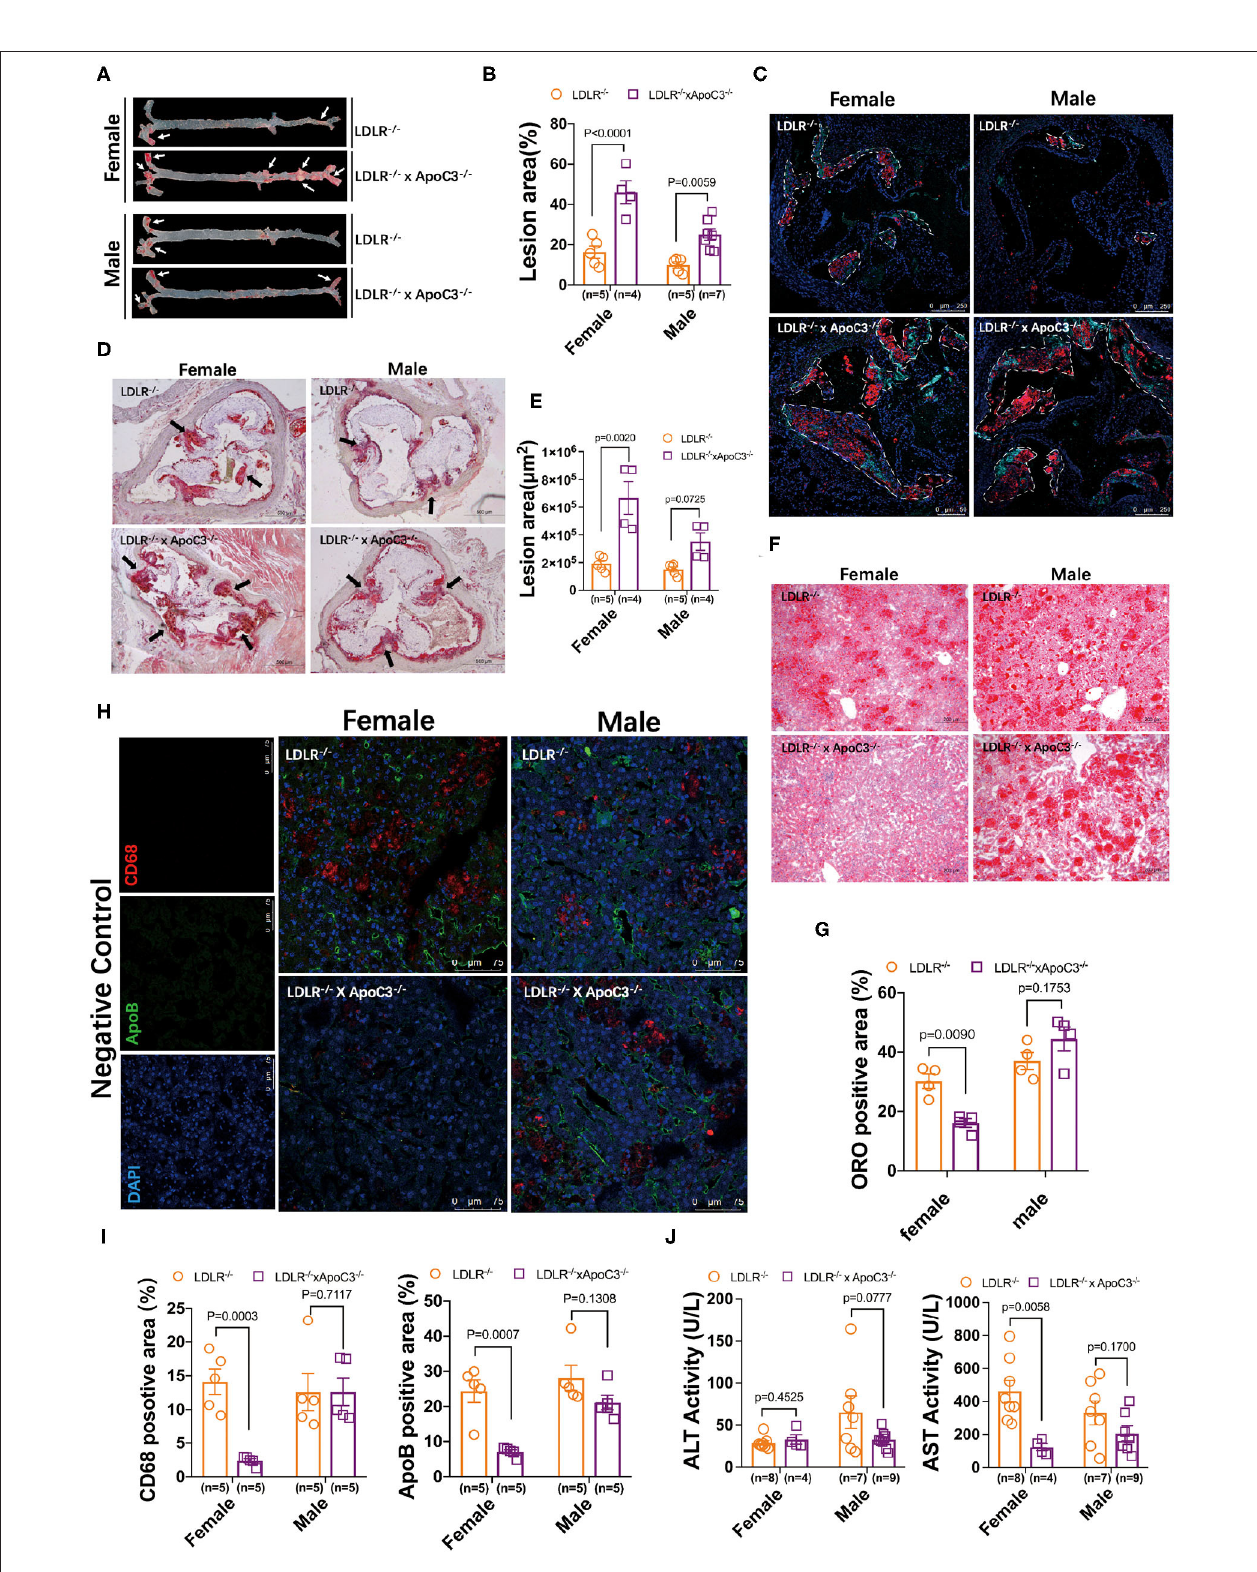
FIGURE 2 | Morphological analysis of atherosclerosis and fatty liver in LDLR − / − and DKO hamsters on HCHF diet. (A) Representative en-face images of the whole aorta. Arrows indicate positive staining. (B) Quantification of the lesion sizes in the whole aorta. (C) Analysis of the components in atherosclerotic plaques by immunofluorescence in HCHF diet-fed animals. Representative staining of ApoB and CD68 in the atherosclerotic lesions of the aortic root. The areas enclosed by